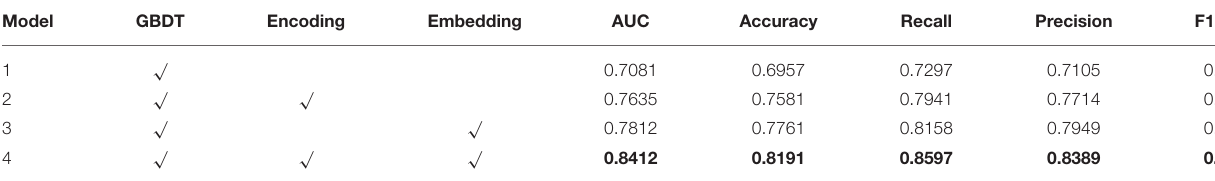
TABLE 4 | Result of all cases where each proposed method can be applied.